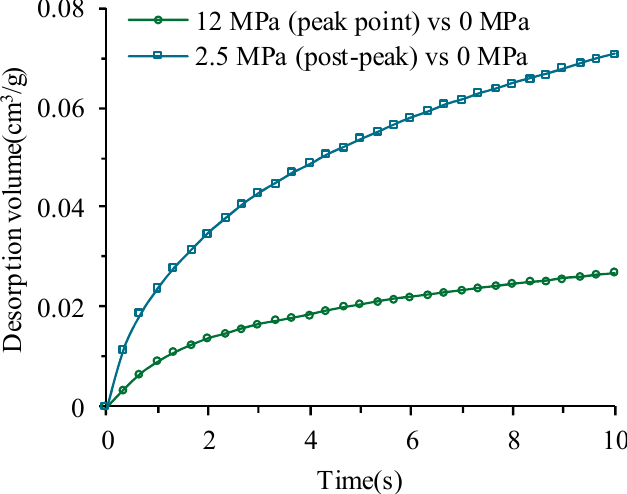
Figure 4. The difference in released methane volume between 12 MPa (peak point), post-peak 2.5 MPa and the pre-peak 0 MPa.